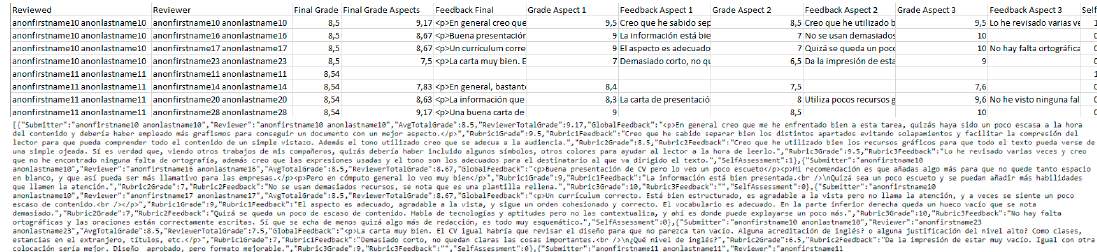
Figure 9. Excerpts of the MS Excel (top) and raw JSON (bottom) output files returned by MWDEX.